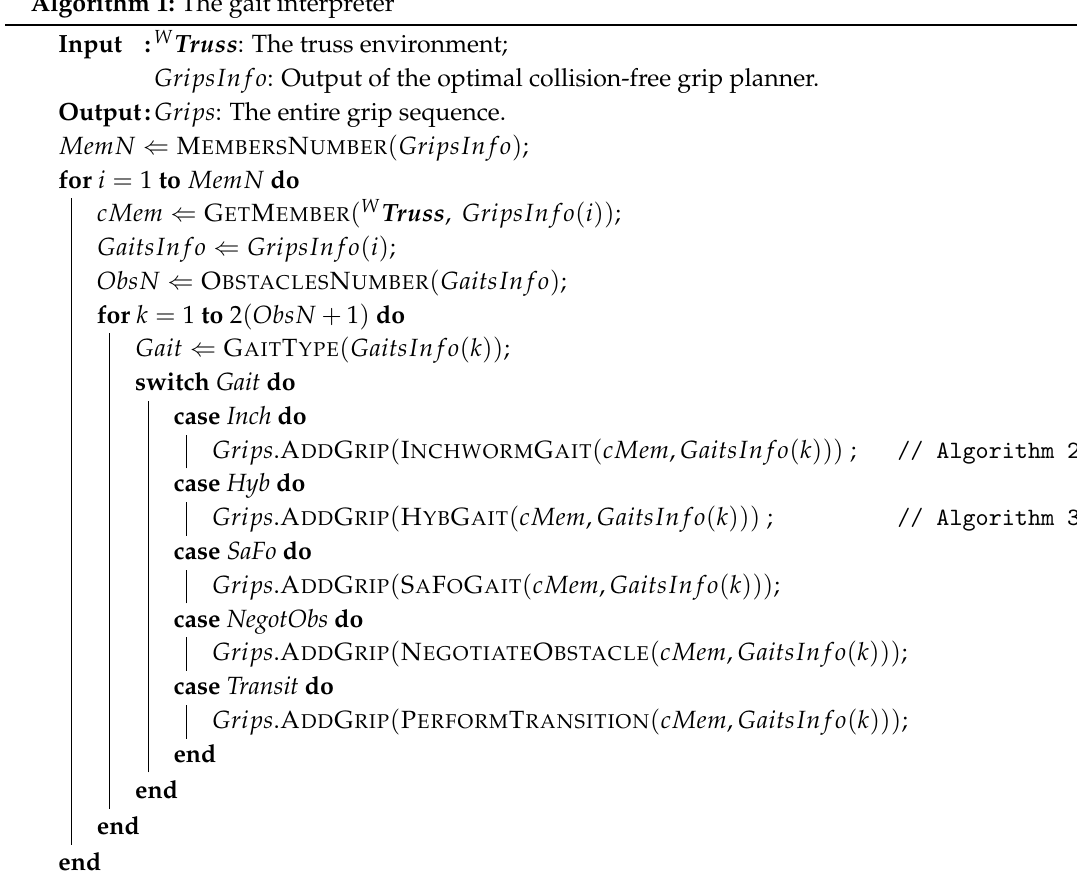
Algorithm 2 is the implementation of the sub-function I NCHWORM G AIT . I NCHWORM G AIT